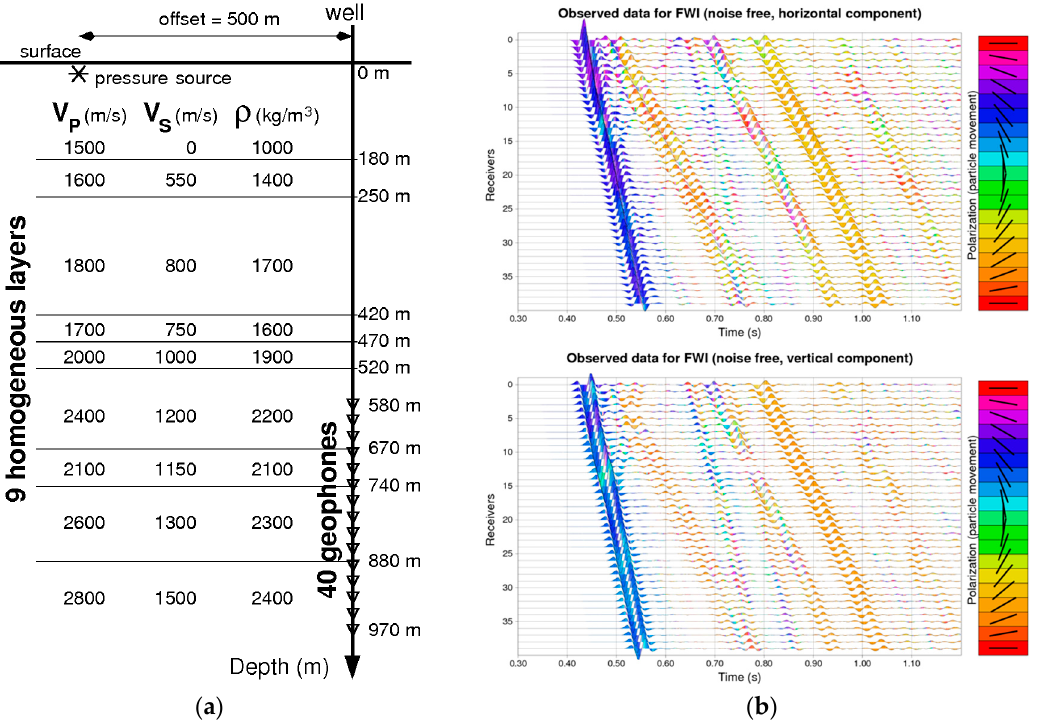
Figure 1. Offset Vertical Seismic Profile (OVSP) numerical experiment: ( a ) Synthetic experiment configuration where the asterisk near the surface denotes the source position for the unique shot point, whereas the triangles in the well denote the location of the 40 two-component geophones. The “true” model is composed of nine homogeneous layers, the first one being the water layer. This true model is used both to model the observed data and as a reference to check inversion results; ( b ) the horizontal (top) and vertical (bottom) components of the ground velocity field recorded at geophones—the fields are obtained by modeling the wave equation in the true model (finite difference approximation). The color represents the local polarization estimated using a 2-period time window.